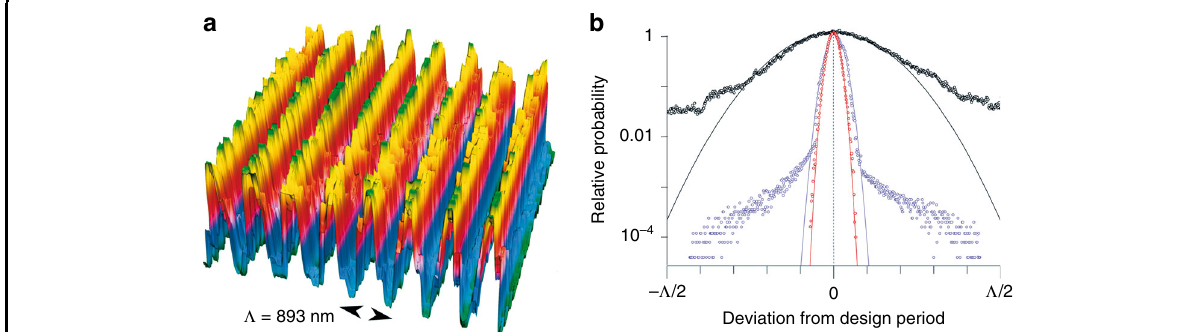
Fig. 1 Grating regularity. a 3D visualization of a small-scale cut out of Fig. 2a of Ref. 3. b Extracting the grating phase from this fi gure via the Hilbert transform 8 , one can evaluate deviations from perfections, which is shown in terms of relative probabilities vs. deviation in units grating period (red symbols). For comparison, the identical analysis was run for two commercial replicated ruled gratings (black 6 , blue 7 ). Parabolic fi ts (curves) indicate the prevalent character of short-term noise excursions; deviations from these fi ts are indicative of slower drift-like deviations from the desired grating